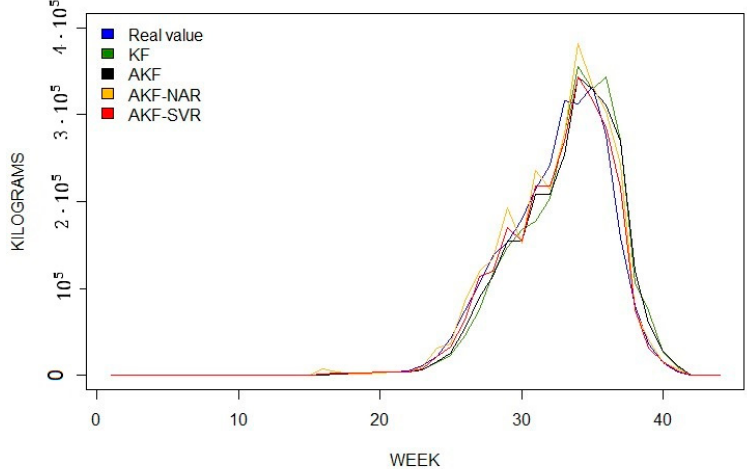
Figure 2. Prediction charts for raspberries: 2019–2020 (weekly).